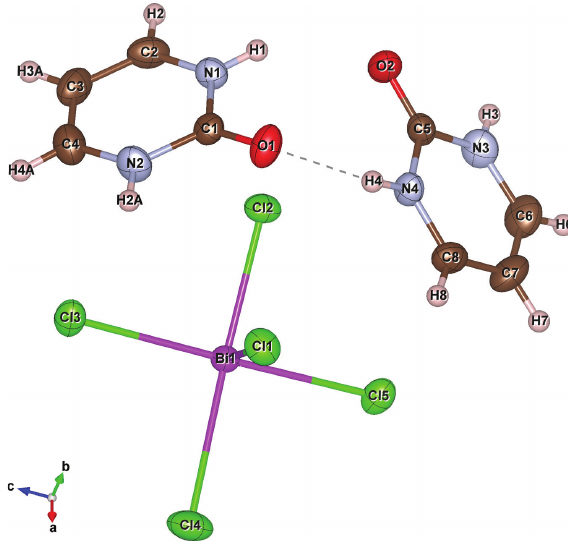
Table 1: Data collection and